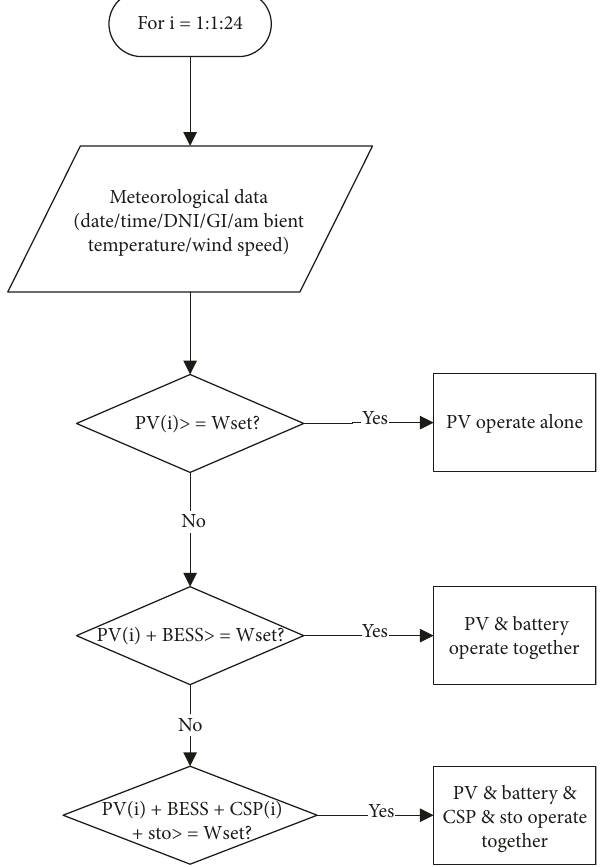
Figure 3: Operation strategy of CSP-PV hybrid power